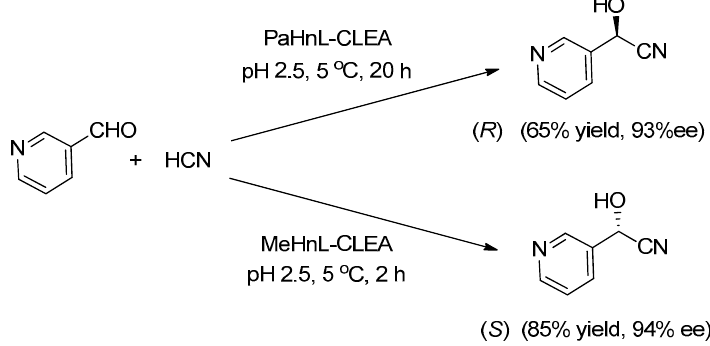
Figure 4. Asymmetric synthesis of cyanohydrins with hydroxynitrile lyase (HNL)-CLEAs.